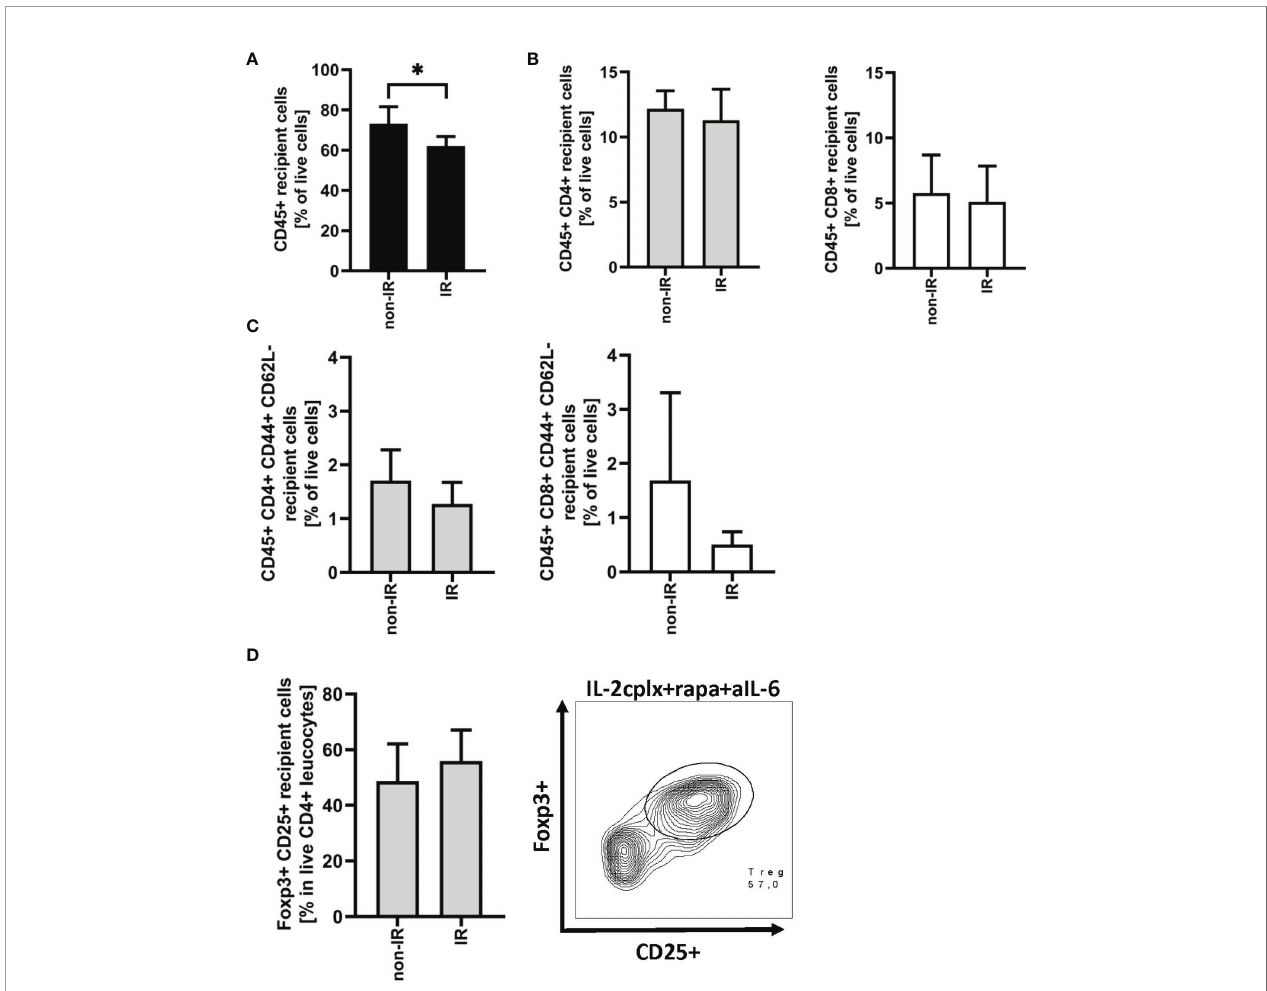
FIGURE 3 | Graft in fi ltrating leucocytes (recipient) 20 days after transplantation. (A) Frequency of CD45+ graft in fi ltrating leucocytes within BALB/c skin grafts that were irradiated (IR) or non-irradiated (non-IR) before transplantation onto IL-2 complex protocol treated C57BL/6 recipients (IR: n = 6; non-IR: n = 7). (B) Frequency of CD4+ (left) and CD8+ (right) allograft in fi ltrating leucocytes. (C) Proportion of CD4+ (left) and CD8+ (right) effector memory T cells found within previously irradiated or non-irradiated skin allografts 20 days after transplantation. (D) Percentage of regulatory T cells (CD45+ CD4+ Foxp3+ CD25+) in the CD45+ CD4+ T cell population present within the skin graft 20 days after transplantation (left). Representative contour plot of regulatory T cell frequency within CD45+ CD4+ graft in fi ltrating cells if recipient was treated with IL-2cplx protocol (right). Analysis (A – D) was performed using fl ow cytometry and mean percentages of two independent experiments of IL-2cplx protocol treated recipients transplanted with irradiated (n = 6) or non-irradiated (n = 7) skin graft are shown. Error bars indicate SD. (*P < 0.05; two-tailed t test with unequal